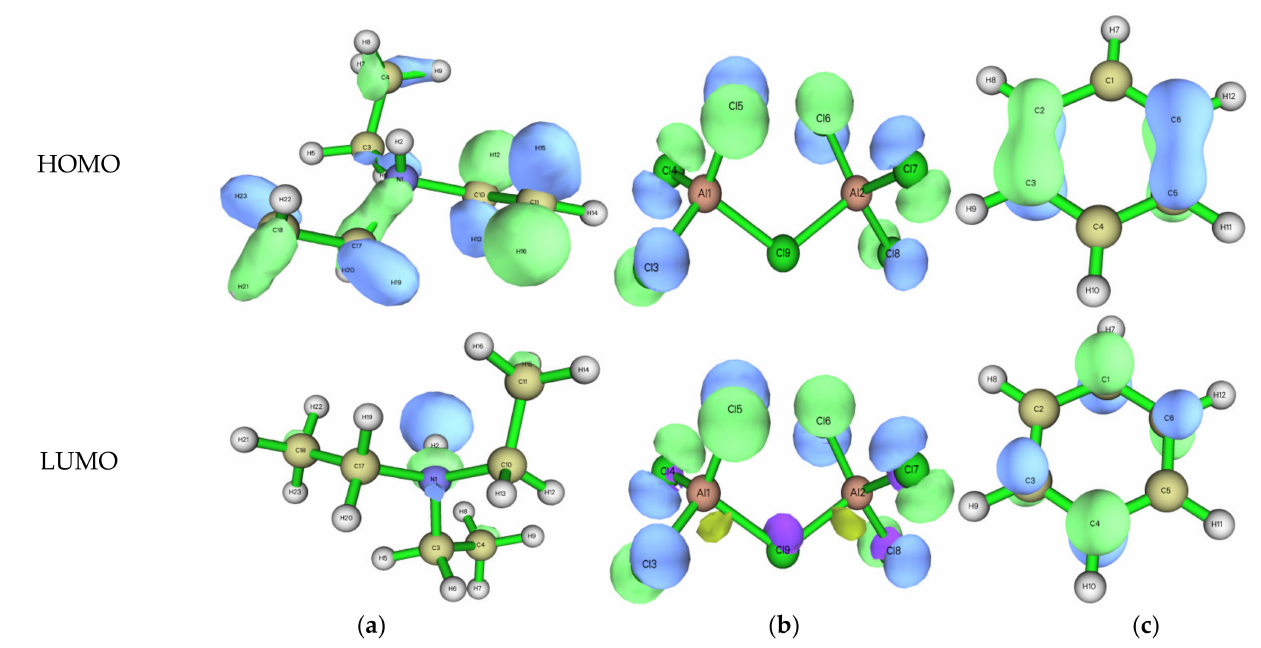
Figure 6. The calculated HOMO and LUMO from B3LYP/6-311++G(d,p) for ( a ) Et 3 NH + ; ( b ) Al 2 Cl 7 − and ( c ) C 6 H 6 . The green and blue color in the figure represents the positive phases and negative phases of the orbital